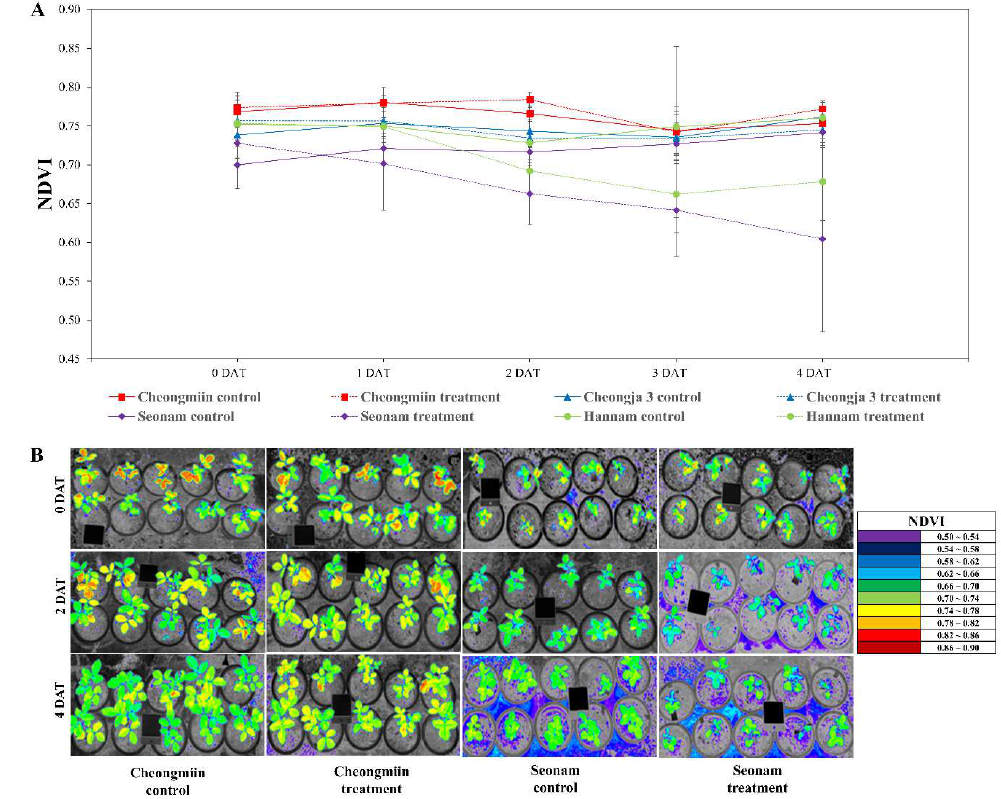
Figure 2. Vegetative index and hyperspectral images of bentazone-treated and control soybean plants. ( A ) Normalized difference vegetative index (NDVI). The 0 days after treatment (DAT) corresponds to the date before treatment. The bars represent standard deviations. Different colors represent the different soybean cultivars. Solid lines are the soybean cultivars with control treatment and dotted lines are soybean genotypes with bentazone treatment ( B ) Differences in hyperspectral images between control and treated tolerant cultivar, Cheongmiin, and sensitive cultivar, Seonam, as shown by computed spectral rations for NDVI.